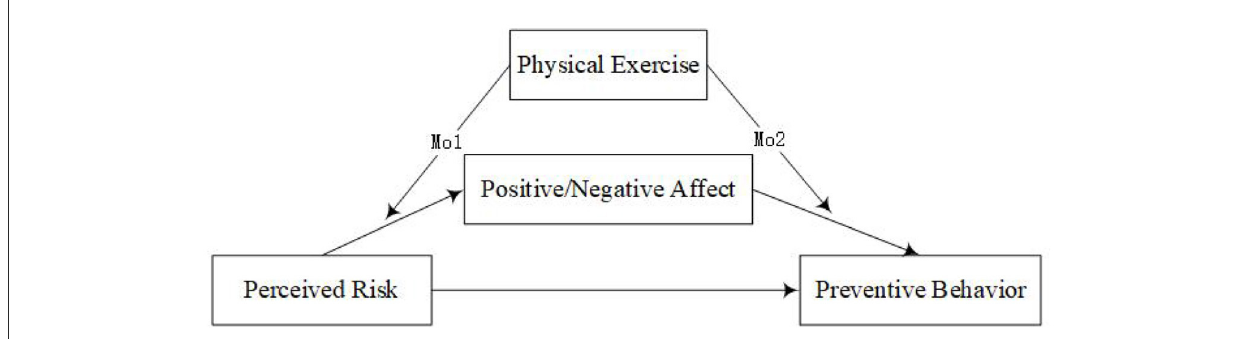
FIGURE1 Conceptual framework of the proposed moderated mediation model. Mo1 refers to the first half of the mediating effect of physical exercise moderation; Mo2 refers to the second half of the mediating effect of physical exercise